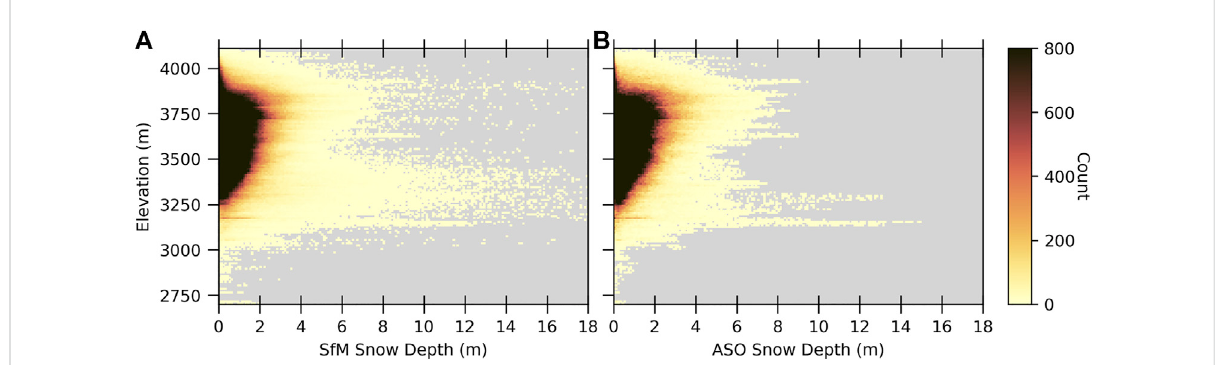
FIGURE 6 Snow depth distribution across elevation bands of 10 m for SfM (A) and ASO (B) at 3 m resolution. Both had similar patterns of higher depth values in the upper elevations between ~3,500 m and ~3,800 m. The higher snow depth spread in the lower elevation between 3,200 m and 3,500 m by SfM is attributed to more areas with